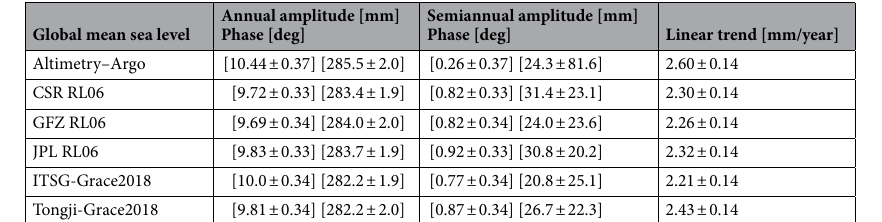
Table 3. Amplitudes and phases of annual and semiannual components and linear trends of GMOM change from altimetry–Argo and GRACE observations over the period from January 2005 to December 2016.